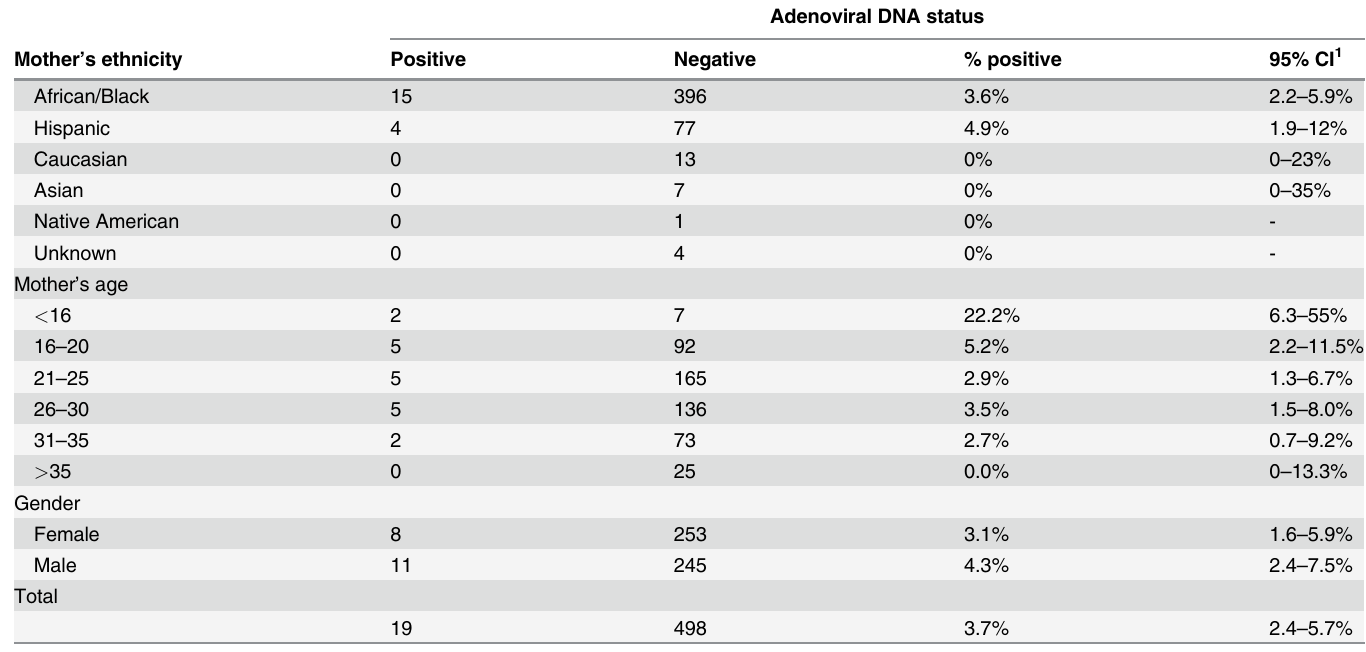
Table 1. Adenoviral DNA status as a function of mother ’ s demographics and infant